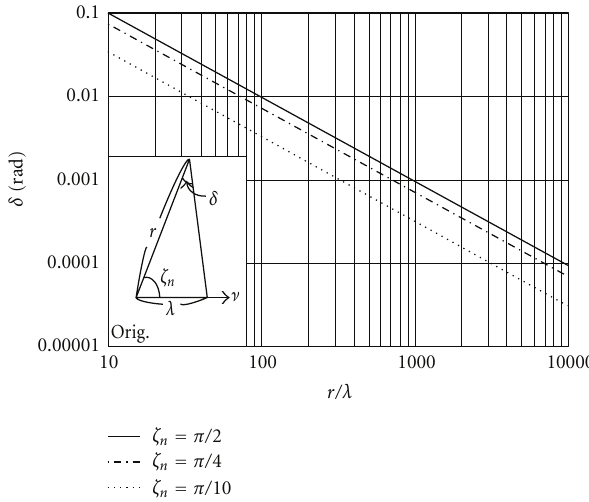
Figure 2: Angle di ff erence δ from ξ n or ζ n (for space λ from origin).